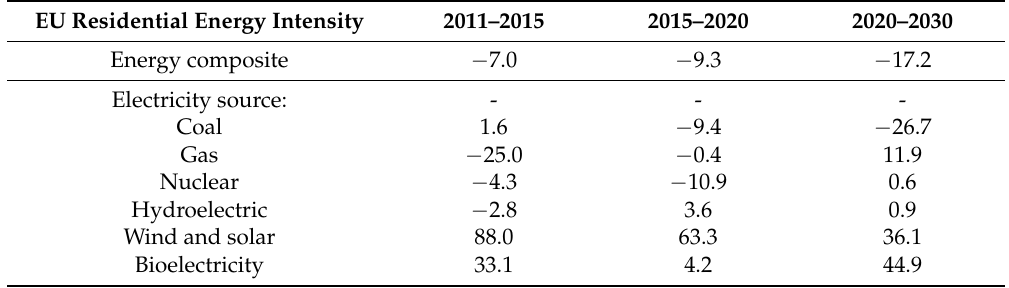
Table 2. EU private energy consumption and gross electricity generation output by technology (%). EU Residential Energy Intensity